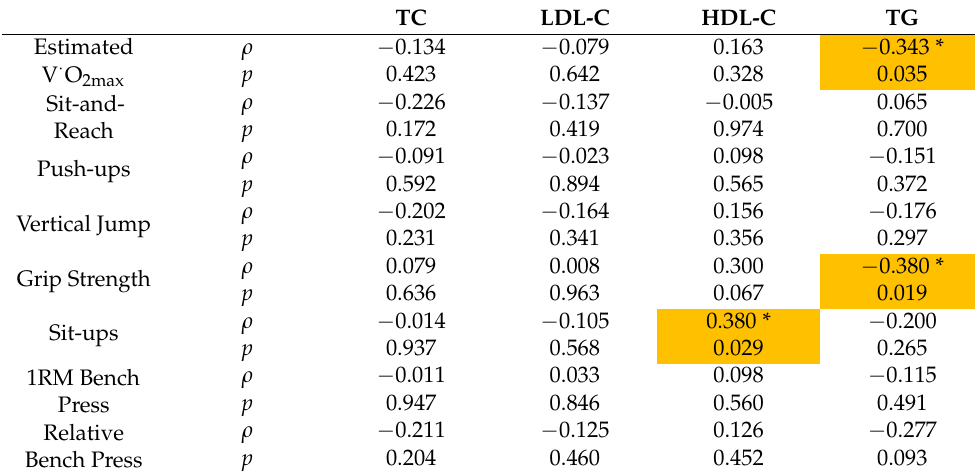
Table 4. Relationships between blood lipids (total cholesterol (TC), low-density lipoproteins (LDL-C), high-density lipoproteins (HDL-C), and triglycerides (TG)) and fitness (estimated maximal aerobic capacity (V · O 2max ), sit-and-reach, push-ups, vertical jump, grip strength, sit-ups, one-repetition maximum (1RM) bench press, and relative bench press) in male police officers ( n = 169) from a health and wellness program in 2018. Significant relationships are highlighted in orange. TC LDL-C HDL-C TG ρ − 0.048 − 0.118 0.291 * − 0.158 * Estimated p 0.542 0.129 <0.001 0.041 V · O 2max ρ 0.046 0.046 0.112 − 0.108 Sit-and- p 0.556 0.559 0.149 0.163 Reach ρ 0.096 0.079 0.175 * − 0.105 Push-ups p 0.216 0.310 0.023 0.175 ρ − 0.079 − 0.094 0.083 − 0.087 Vertical Jump p 0.314 0.233 0.291 0.266 ρ − 0.004 − 0.037 0.169 * − 0.121 Grip Strength 0.963 0.636 0.028 0.118 ρ − 0.041 − 0.066 0.138 − 0.233 * Sit-ups p 0.613 0.415 0.089 0.004 ρ − 0.141 − 0.102 0.016 − 0.112 1RM Bench p 0.069 0.190 0.839 0.149 Press ρ − 0.024 − 0.013 0.157 * − 0.144 Relative p 0.762 0.872 0.042 0.063 Bench Press * Significant ( p < 0.05) relationship between the two variables. Table 5. Relationships between blood lipids (total cholesterol (TC), low-density lipoproteins (LDL-C), high-density lipoproteins (HDL-C), and triglycerides (TG)) and fitness (estimated maximal aerobic capacity (V · O 2max ), sit-and-reach, push-ups, vertical jump, grip strength, sit-ups, one-repetition maximum (1RM) bench press, and relative bench press) in female police officers ( n = 39) from a health and wellness program in 2018. Significant relationships are highlighted in orange. TC LDL-C HDL-C TG ρ − 0.134 − 0.079 0.163 − 0.343 * Estimated p 0.423 0.642 0.328 0.035 V · O 2max ρ − 0.226 − 0.137 − 0.005 0.065 Sit-and- p 0.172 0.419 0.974 0.700 Reach ρ − 0.091 − 0.023 0.098 − 0.151 Push-ups p 0.592 0.894 0.565 0.372 ρ − 0.202 − 0.164 0.156 − 0.176 Vertical Jump 0.231 0.297 ρ 0.079 0.008 0.300 − 0.380 * Grip Strength 0.067 0.019 −